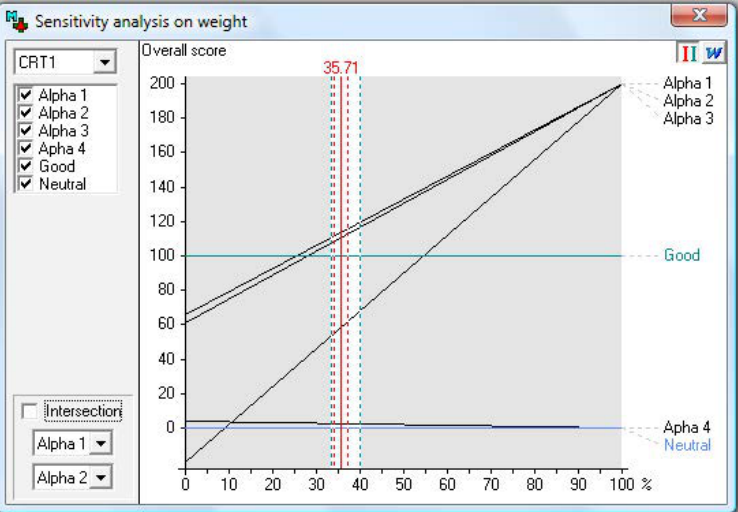
Figure 5. Sensitive analysis on crt